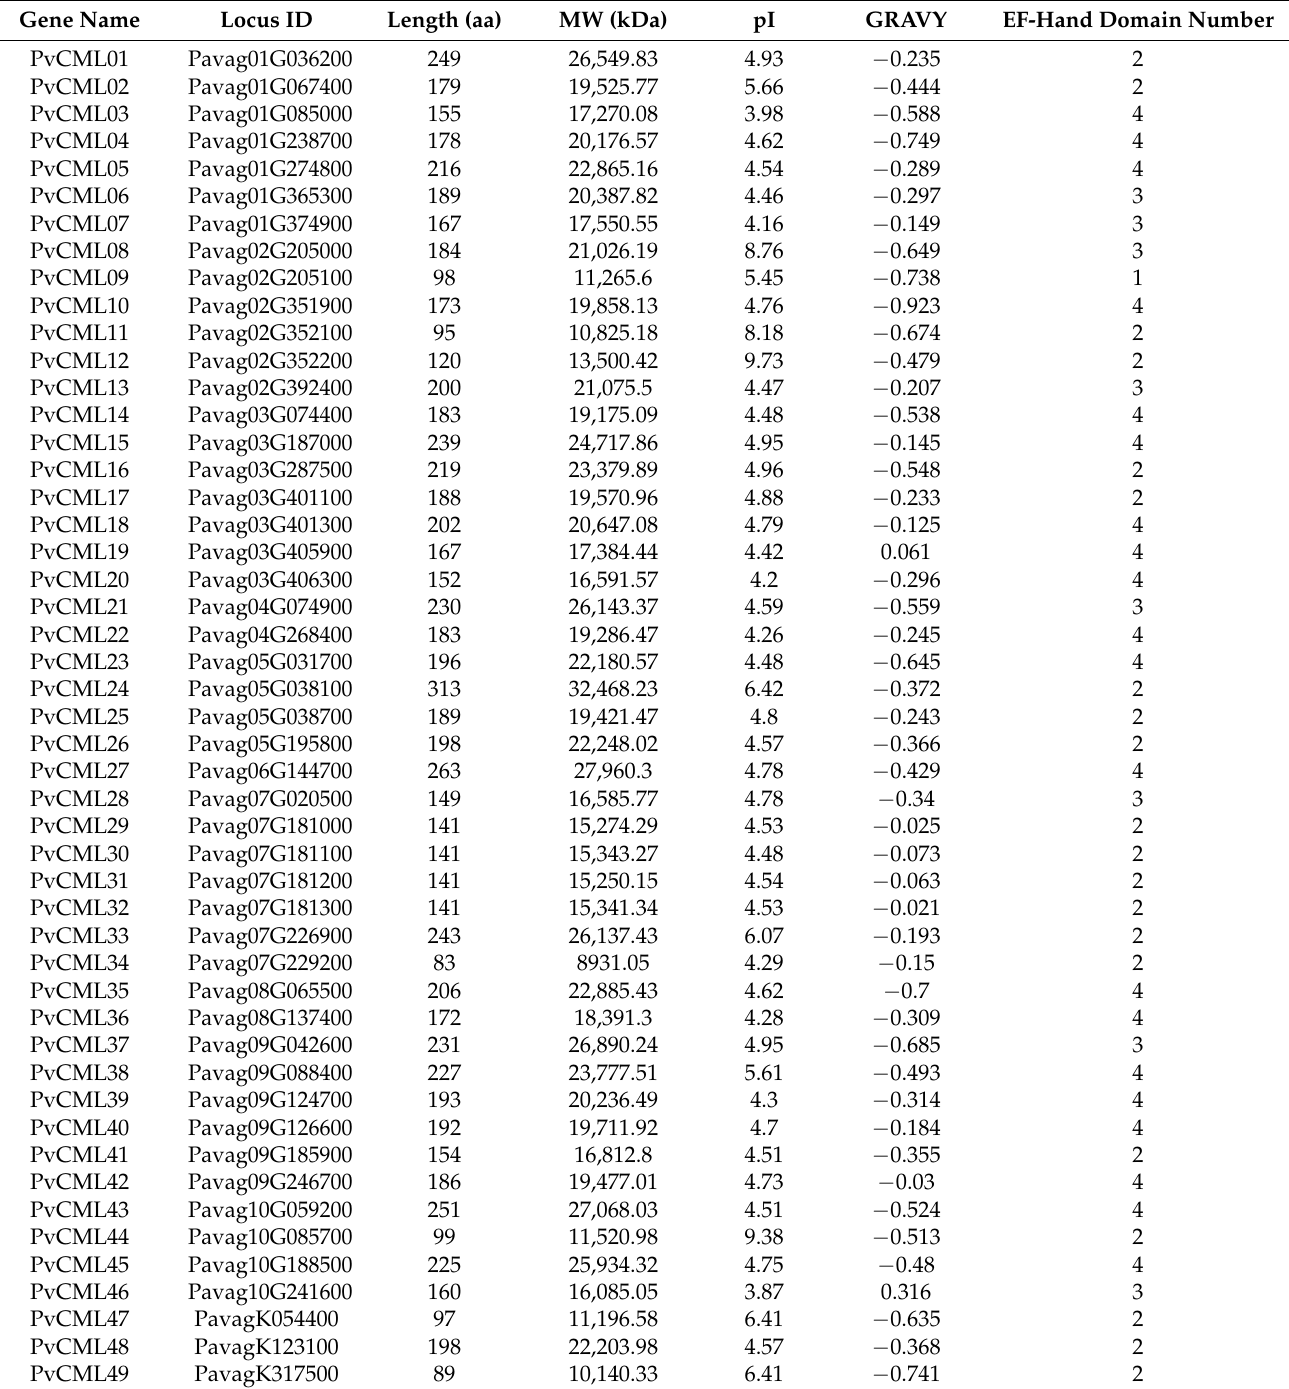
Table 1. Information of PvCMLs identified in the P. vaginatium